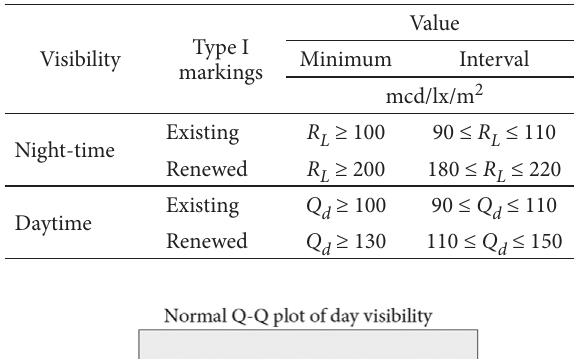
Fig. 2. Measuring vehicle with dynamic retroreflectometer Table 4. Minimum values of visibility for type I markings according to Hrvatske ceste d.o.o on dry road surface